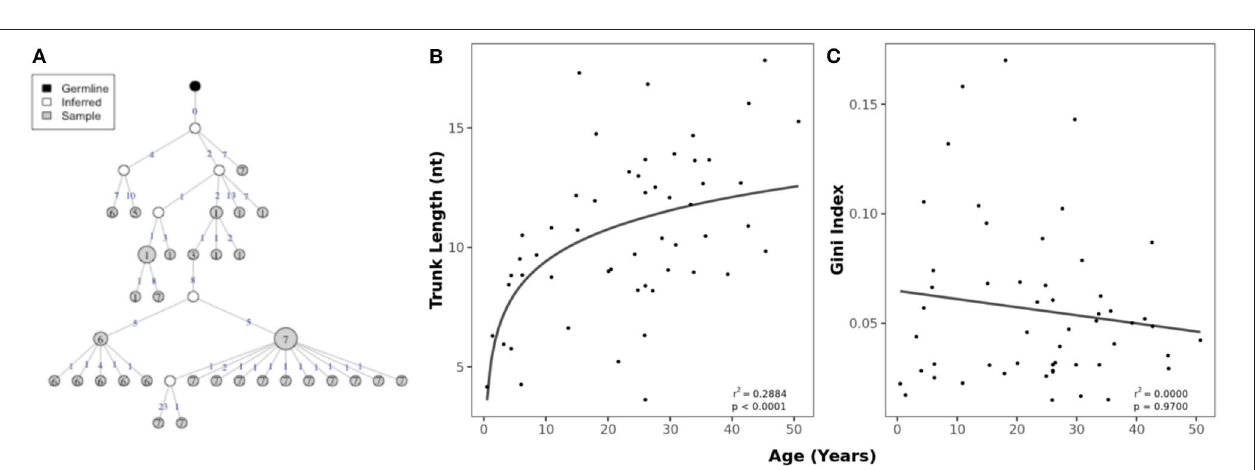
FIGURE 3 | Sharing of sequence and structural clusters among the 53 healthy participants of different ages. (A) Percentage of sequence clusters shared by n individuals. (B) Percentage of structural clusters shared by n individuals. For structural clusters, zeros were replaced by 0.01% to be displayed on a logarithmic scale but labeled as 0%.